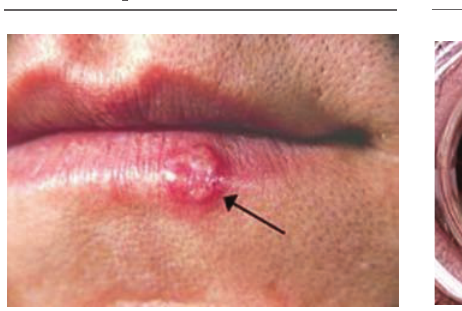
Figure 8. Oral HPV lesion. 8 Reproduced with permission from IAS-USA. Top HIV Med 2005;13:143-8.